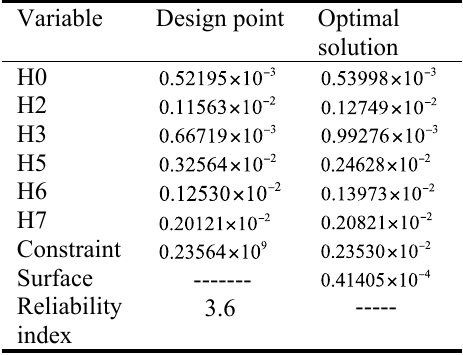
Table 4. Results of the OSF method